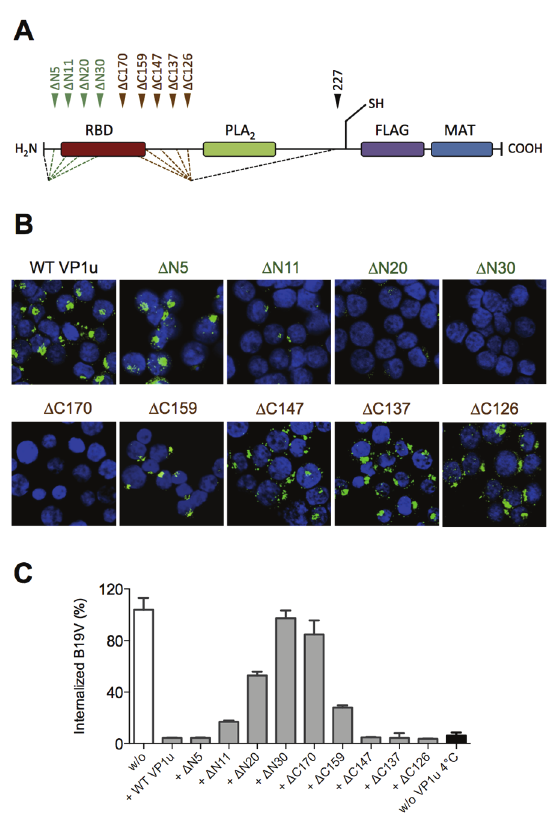
Figure 1. Localization of the receptor-binding domain (RBD) within the VP1u. ( A ) Schematic depiction of the recombinant VP1u protein (227 AA) and the introduced truncations. N-terminal truncations (green): ∆ N5, ∆ N11, ∆ N20, ∆ N30. C-terminal truncations (brown): ∆ C126, ∆ C137, ∆ C147, ∆ C159, ∆ C170. Motifs: Receptor-binding domain (RBD, brown); phospholipase A2 (PLA2, AA 130–195, green [33]); introduced unique cysteine (C228); FLAG tag for immunodetection (violet); metal affinity tag (MAT) for Ni-NTA-purification (blue); ( B ) Representative immunofluorescence images of VP1u internalization (green signal) into UT7/Epo cells. VP1u protein variants were internalized at 37 °C for 1 h and detected by α FLAG antibody; ( C ) Quantification of B19V uptake in presence of VP1u protein variants as competitors ( n ≥ 2). Values were normalized to unhindered internalization without VP1u (white bar). Control for no internalization (black bar) was kept at 4 °C instead of incubation at 37 °C. All samples shown in (B,C) were trypsinized after incubation at 37 °C to remove uninternalized VP1u in (B) and B19V in (C), respectively.